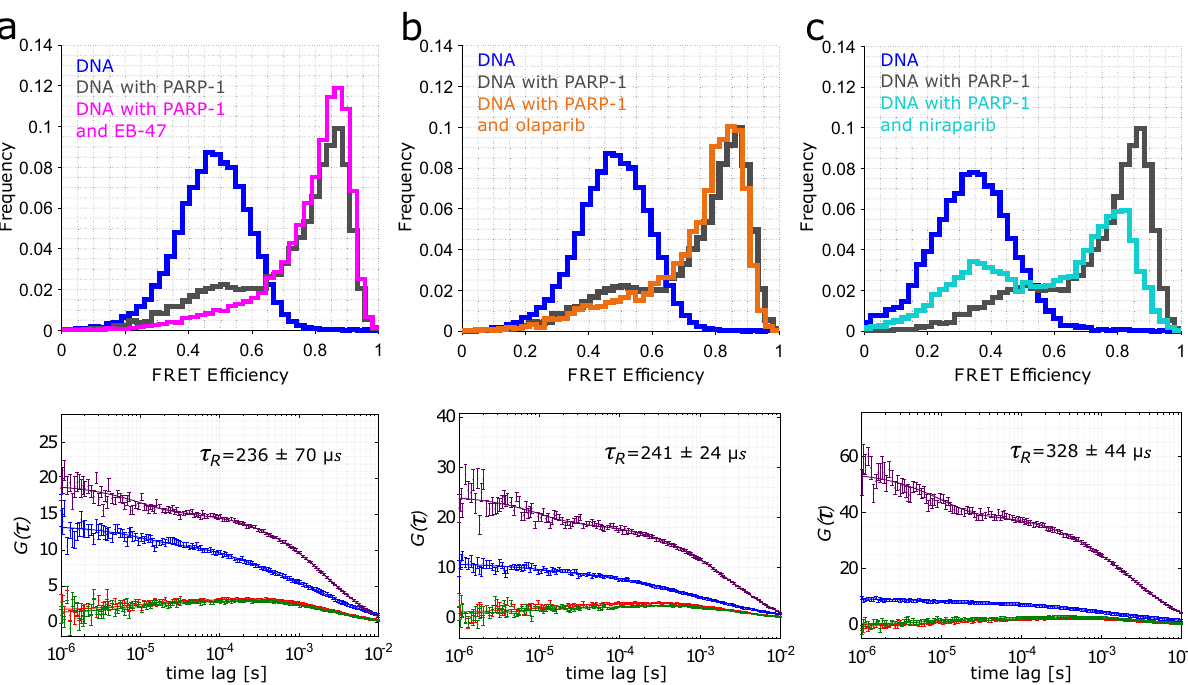
Fig. 6 | DNA conformation probedby smFRET in presence ofPARP-1and PARP inhibitors.a (upper panel)smFRETef fi ciencyhistogram of nicked DNA(blue)and nicked DNA in the presence of either PARP-1 (grey, same histogram as in Fig.1) or PARP-1 and EB-47 (pink), a class I PARP-1 inhibitor. b (upper panel) smFRET ef fi - ciency histogram of nicked DNA (blue), nicked DNA in the presence of PARP-1 (grey), as well as in the presence of PARP-1 and olaparib (orange), a class II PARP-1 inhibitor. c (upper panel) smFRET ef fi ciency histogram of nicked DNA (blue), nicked DNA in presence of PARP-1 (grey), as well as nicked DNA in the presence of PARP-1 and niraparib (turquoise), a class III PARP-1 inhibitor. Note, since niraparib